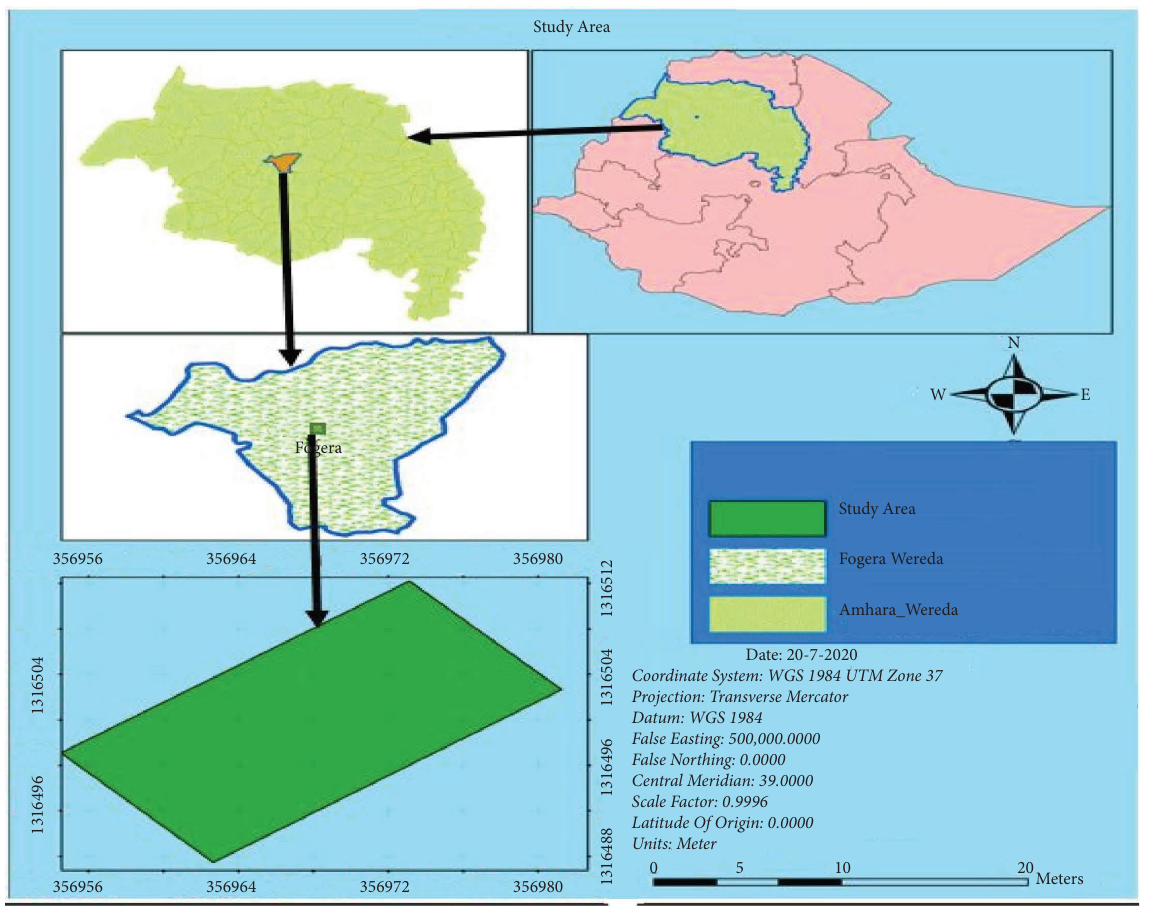
Figure 1: Map of the study area.